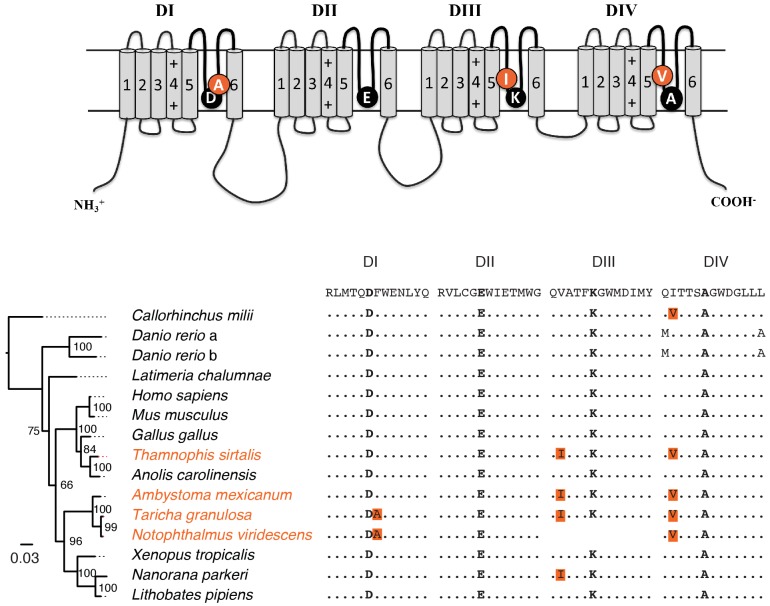
Parallel evolution of DIII and DIV P-loop substitutions in Nav1.6 of toxic newts and TTX resistant garter snakes.Structure of the Nav channel and multiple sequence alignment of Nav1.6 across representative vertebrate taxa. The consensus sequence is shown above the alignment, and orange labels indicate taxa that either possess TTX or consume TTX-laden prey. Identical amino acid substitutions were observed between rough-skinned newts (Taricha granulosa) and garter snakes (Thamnophis sirtalis) from Benton Co. OR, where T. granulosa populations are highly toxic. Furthermore, some of these mutations were also identified in the less toxic eastern newt (Notophthalmus viridescens) and the non-toxic axolotl (Ambystoma mexicanum). These observations suggest that the last common ancestor of Ambystomids and Salamandrids possessed replacements in DIII and DIV. Our physiological data indicate that these replacements provide low levels of resistance, and may have thus allowed low level exposure to TTX, possibility facilitating the evolution of TTX toxicity in some Salamandrid species. Phylogenetic relationships are based on full-length Nav1.6 assessed by RAxML with 1000 bootstrap replicates. Support values are shown on each node, and the scale bar reflects the mean number of nucleotide substitutions per site.